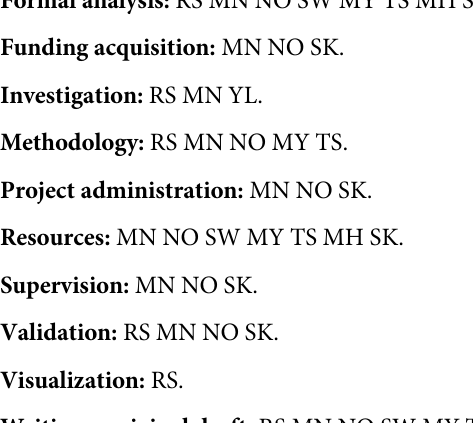
O or 200 nM of 2 2